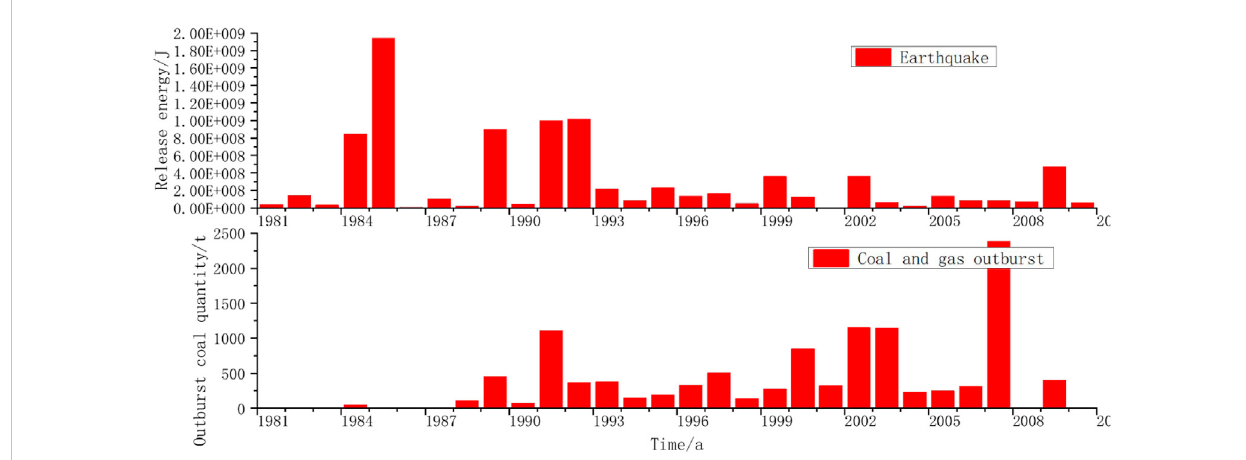
FIGURE 8 Comparison histogram of annual coal and gas outburst and annual energy released by natural earthquake in Pingdingshan eastern mining area.